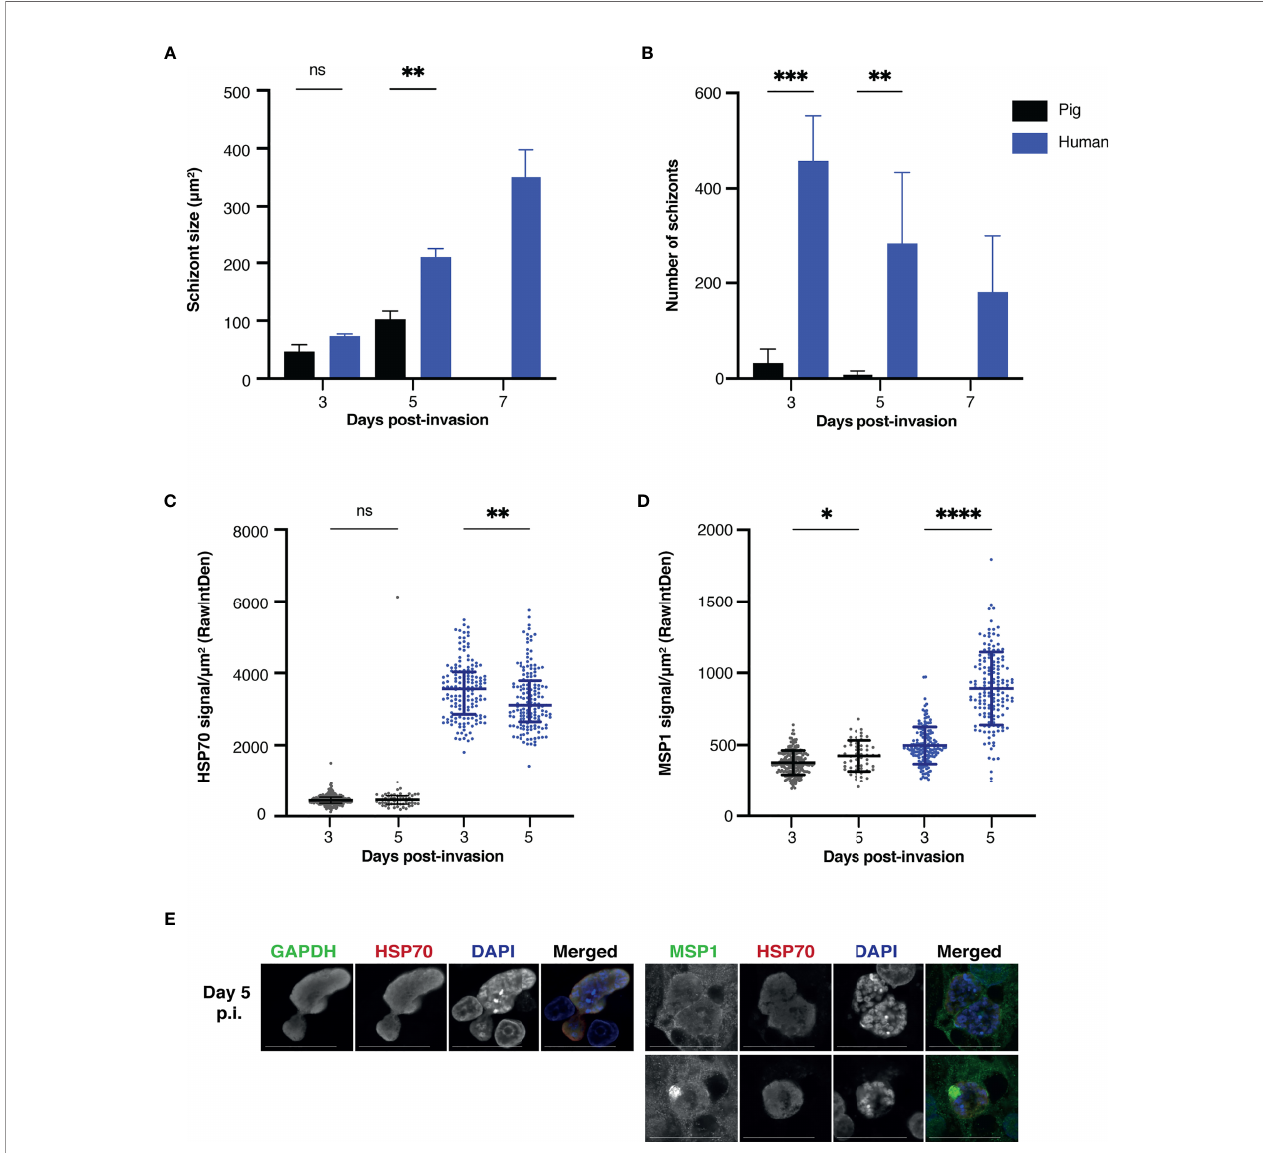
FIGURE 2 | (A) Schizont size. Mean sizes (±SD) of NF135.C10 schizonts on day three, day fi ve and day seven post-invasion in primary porcine and human hepatocytes based on immuno fl uorescence staining with HSP70. Per technical replicate, all or up to seventy- fi ve schizonts were measured for each of the biological replicates (three human and three porcine donors). A two-way RM ANOVA was performed on the median of each replicate. Mean size (±SD) of NF135.C10 schizonts per technical replicate and circumference data is shown in Supplementary Figure 1 and Supplementary Table 1 (B) Schizont number. Mean number (±SD) of NF135.C10 schizonts on day three, day fi ve and day seven post-invasion in primary porcine and human hepatocytes based on immuno fl uorescence staining with HSP70 and DAPI. All schizonts were counted per technical replicate of each of the biological replicates. A two-way RM ANOVA was performed on the median of each replicate. The mean number (±SD) of NF135.C10 schizonts per technical replicate is shown in Supplementary Figure 2 (C) HSP70 signal. The median HSP70 signal (±IQR) measured per schizont on day three and day fi ve post-invasion is shown, corrected for noise and schizont size. All or up to fi fty schizonts were measured per technical replicate of the three biological replicates. A two-way RM ANOVA was performed on the median of each replicate. (D) MSP1 signal. Median MSP1 signal (±IQR) measured per schizont on day three and day fi ve post-invasion, corrected for noise and schizont size. All or up to fi fty schizonts were measured per technical replicate of three biological replicates. A two-way RM ANOVA was performed. (E) Expression of typical liver stage protein markers in porcine hepatocytes visualized by confocal microscopy including GAPDH, HSP70, MSP1 and DAPI. For comparative human images, please refer to (Yang et al., 2021). Objective 63×; zoom 2×; scale bar 25 µm. For panels A, C and D, the total number of schizonts analyzed per condition is shown in Supplementary Table 2 . RawIntDen: raw integrated density. GAPDH, glyceraldehyde 3-phosphate dehydrogenase; HSP70, heat shock protein 70; IQR, interquartile range; MSP1, merozoite surface protein; NS, not signi fi cant; P.I., post-invasion; IQR, interquartile range. *P < 0.05; **P < 0.005; ***P < 0.001; ****P <